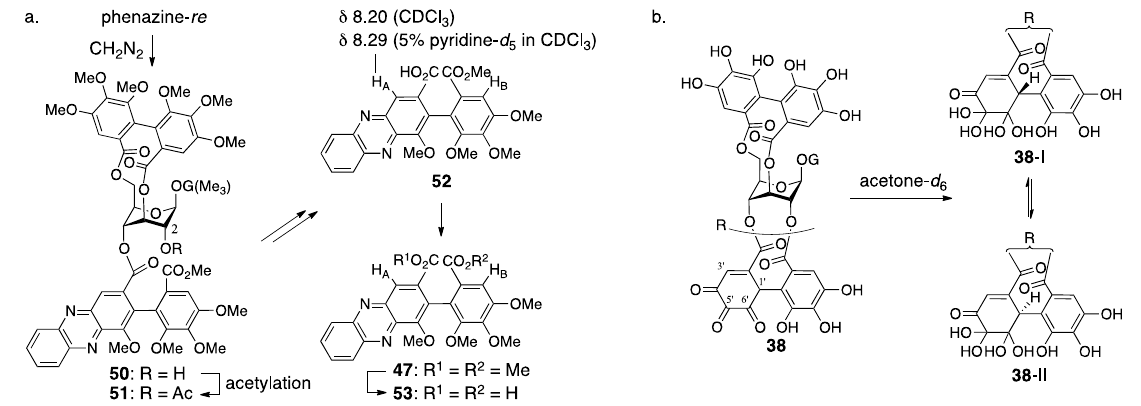
Figure 21. ( a ) The transformations that lead to the second structure of geraniin ( 38 ) and ( b ) the equilibrium between the two hydrated structures.